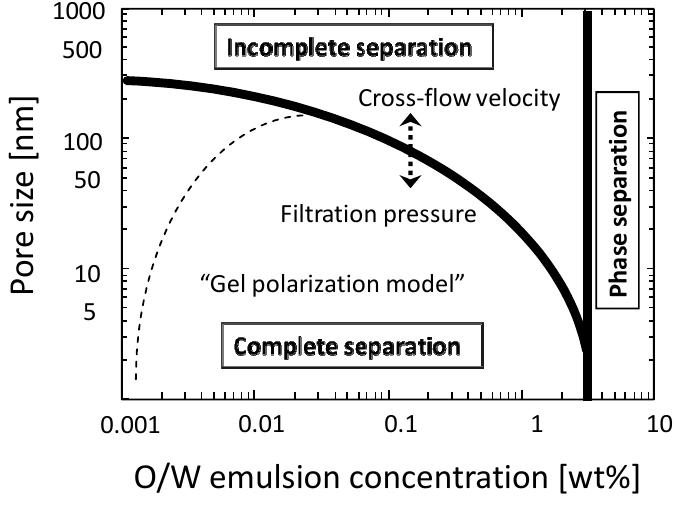
Figure 7. Diagram for the relationship between the membrane filtration properties and the filtration